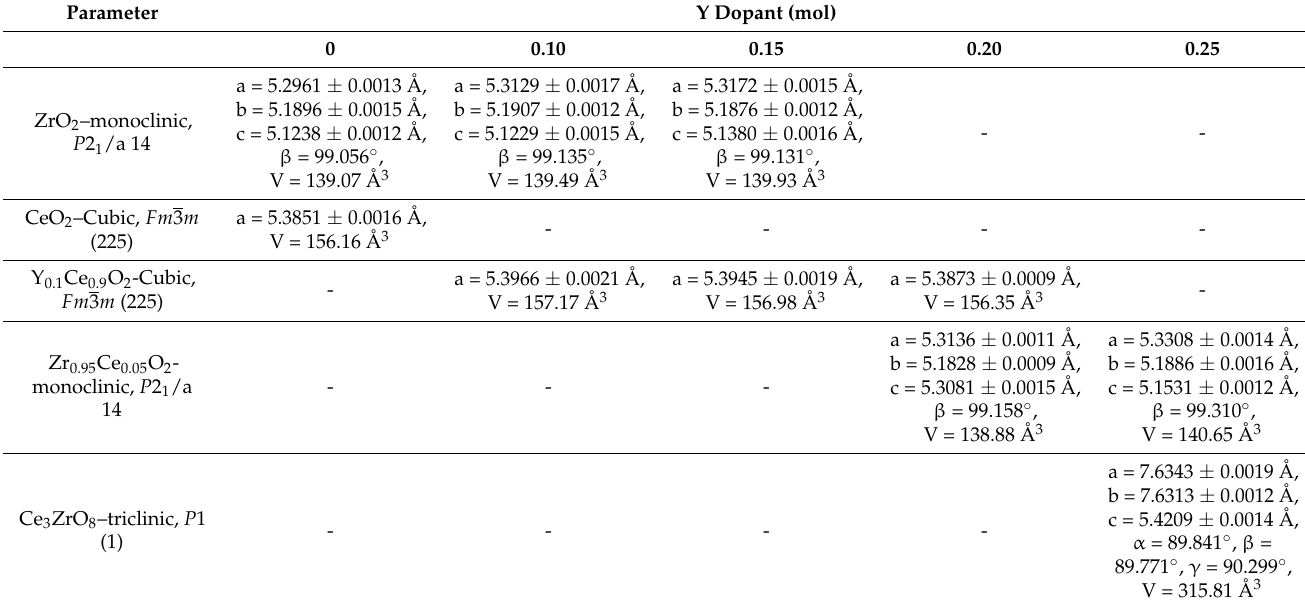
Table 1. Data of the crystal lattice parameters of the studied